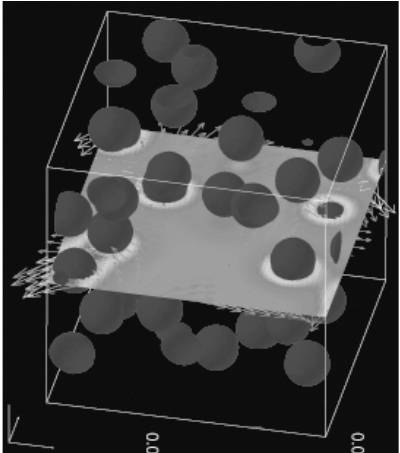
Fig. 5 A colloidal particle (colored blue) in electrophoretic motion un- der an external electric field applied in the + x direction.